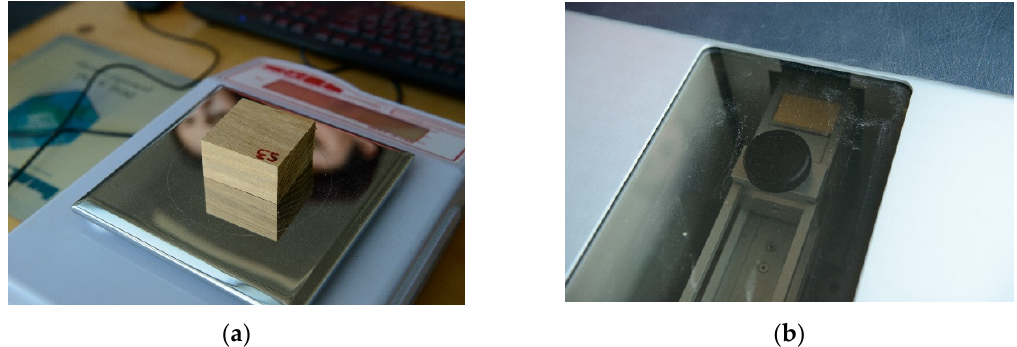
Figure 2. X-Ray Density Profile Analyzer DPX300: ( a )weighting the samples; ( b )the samples in the X–ray device train.